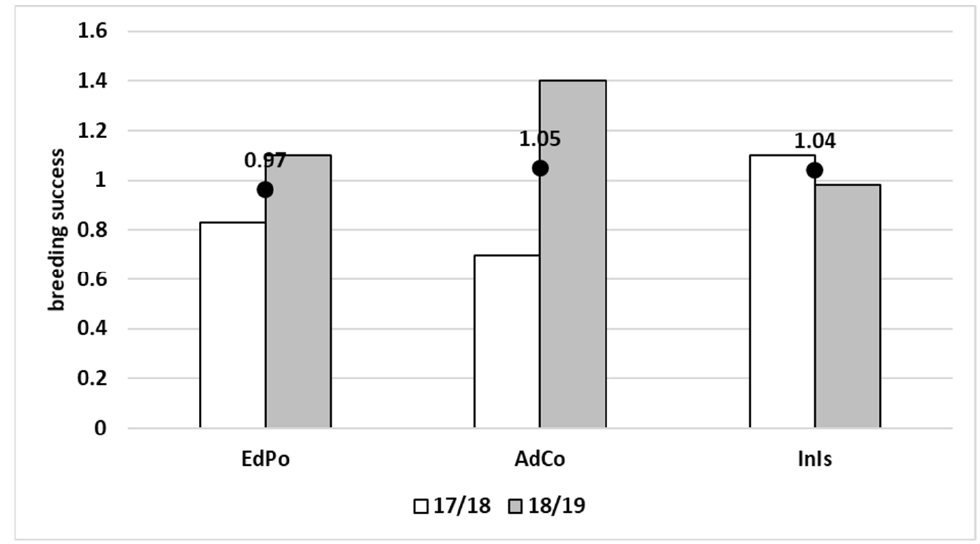
Figure 5. Breeding success for the three colonies in 2017/2018 (white bars) and 2018/2019 (gray bars). Black dot is the mean value across the two study years. Data for InIs in 2018/2019 were retrieved from [43].